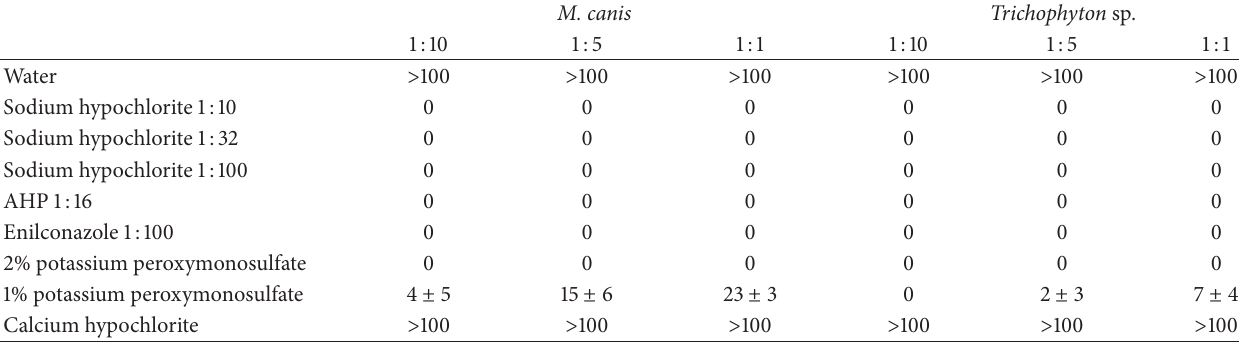
Table 1: Mean number of colony forming units after exposure to disinfectants. M.